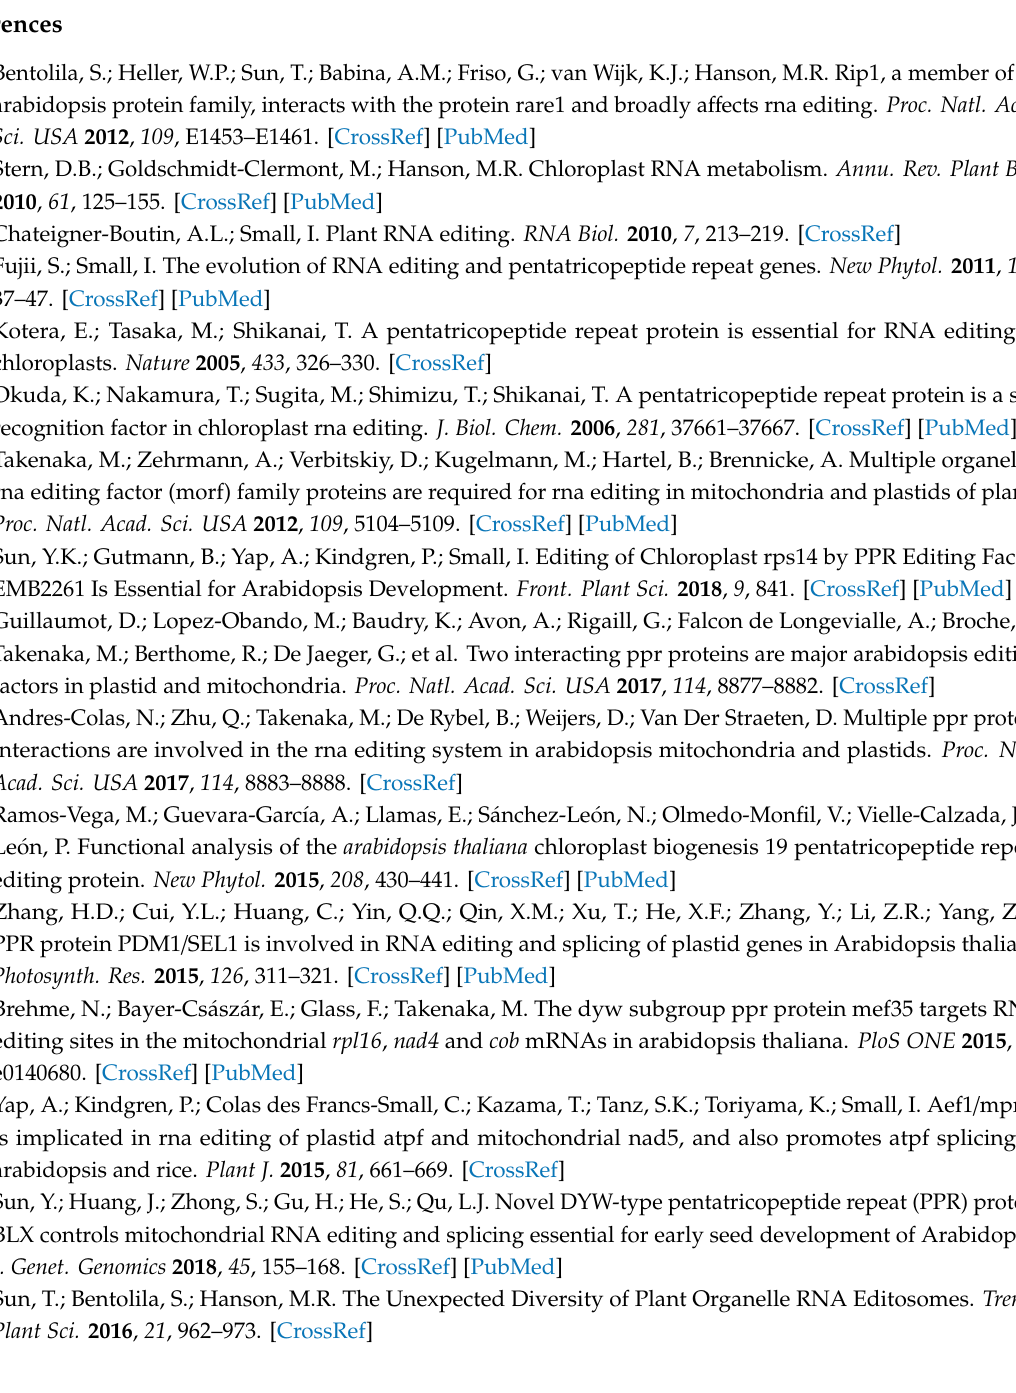
e ffi ciency of plastid RNA editing